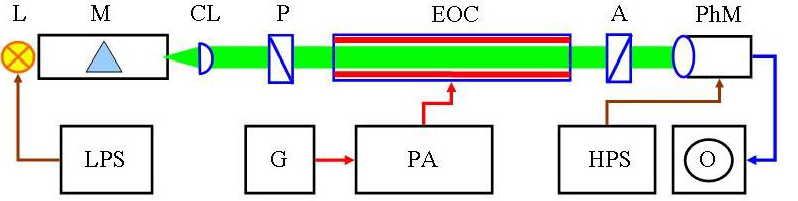
Figure 7. Schematic diagram of the set-up used for electric birefringence: L—halogenous lamp 12 V, 100 W; LPS—low-voltage power supply unit; M—prism monochromator; CL—cylindrical lens; P— polarizer; EOC—electrooptical cell; A—analyzer; PhM—photomultiplier; HPS—high-voltage power supply unit; O—digital oscilloscope; G—functional generator; PA—wide band power amplifier. The coloured components are: lamp (yellow); light beam (green), metal electrodes (two thick red lines in EOC); electric impulses (red lines); electrooptical signal (blue line), low- and high-voltage direct current (brown lines).